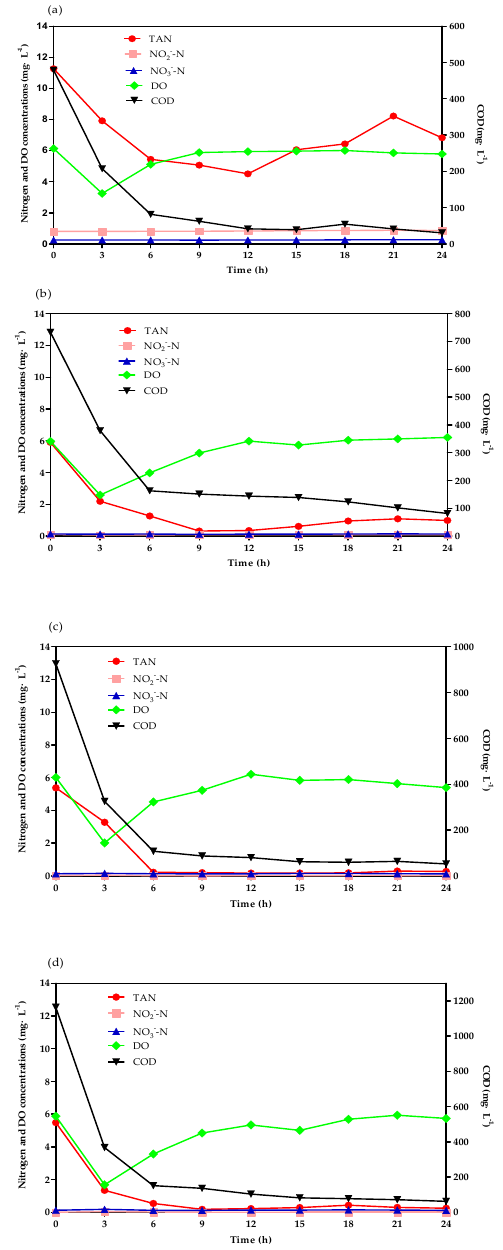
Figure 2. Dynamics of nitrogen concentrations, COD and dissolved oxygen (DO) in the suspended growth bioreactors (SGBRs) of a whole cycle: ( a ) C/N 10 treatment; ( b ) C/N 15 treatment; ( c ) C/N 20 treatment; ( d ) C/N 25 treatment.